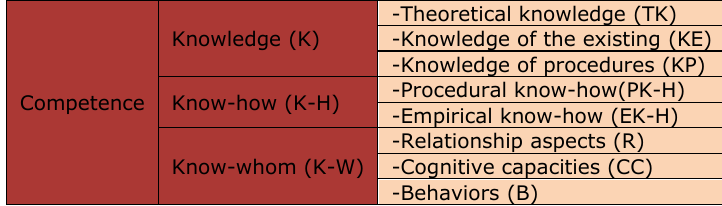
Table 1. Competence resources categorization (Harzallah & Vernadat,